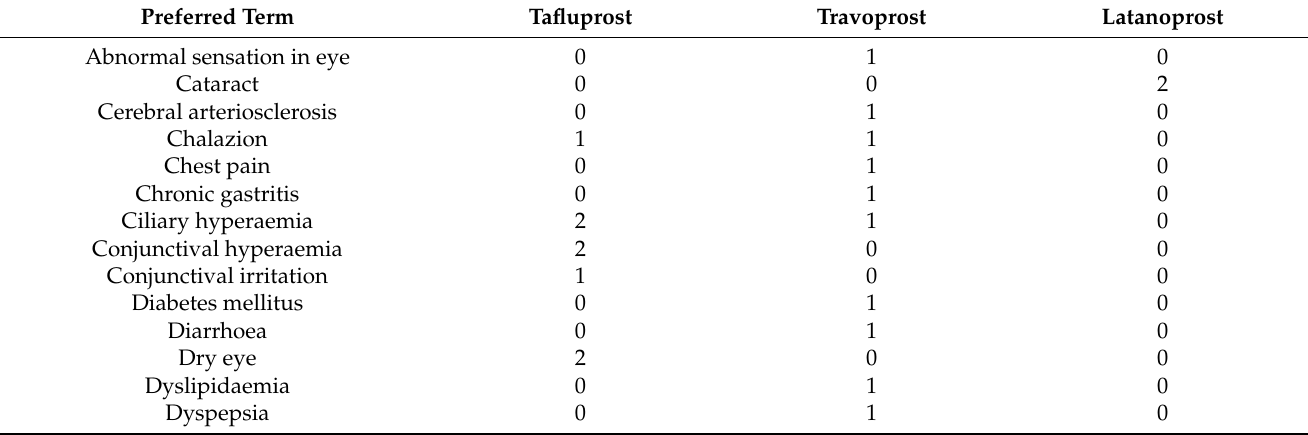
Table 3. Ocular adverse events in patients receiving long-term treatment with tafluprost, travoprost, or latanoprost (safety set). Preferred